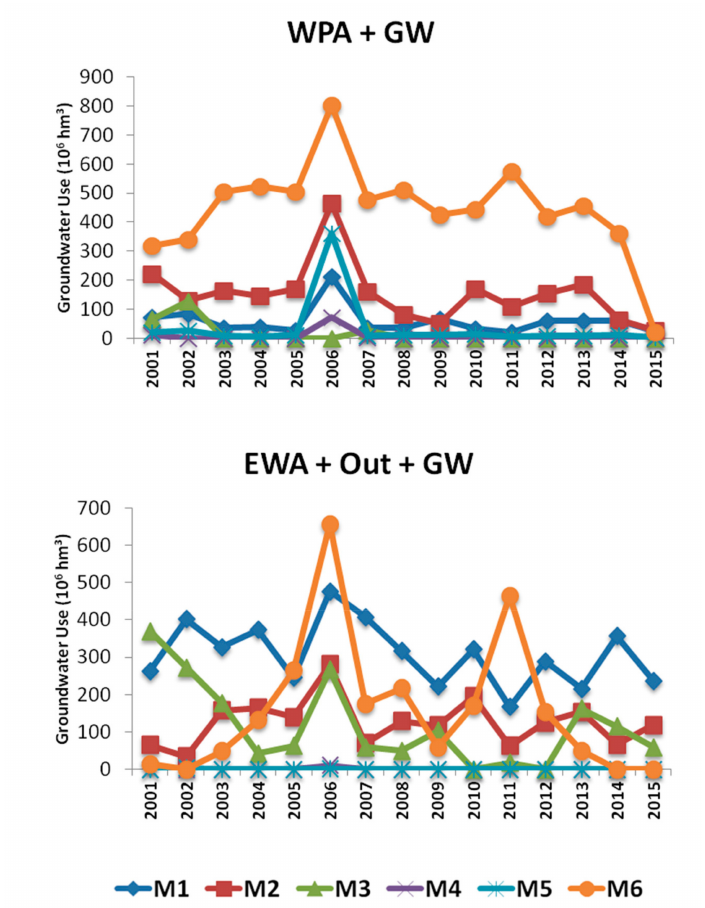
Figure 9. Evolution of groundwater use on the simulations